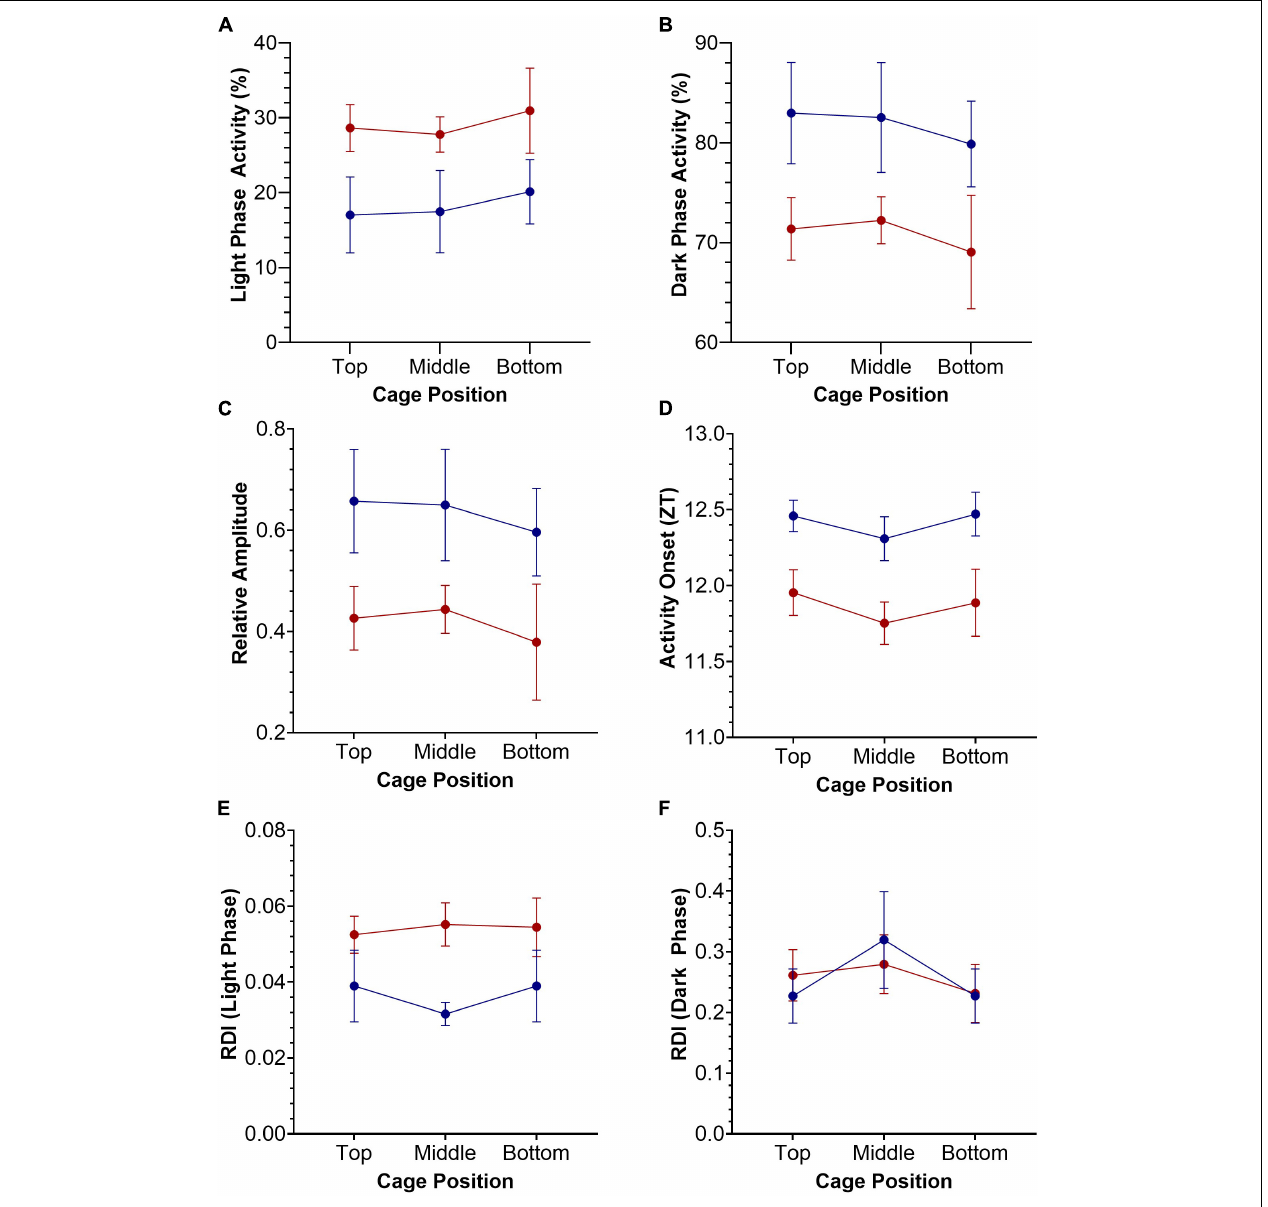
FIGURE 3 | Key circadian activity parameters plotted as mean +/– SEM for standard (blue) and red (red) cages, across top, middle, and bottom positions of the DVC rack. Two-way repeated-measures ANOVAs were used to test for significant effects of cage type and cage position. (A) Light phase activity (%), main effect of cage type [ F ( 1 . 0 , 9 . 0 ) = 4.196, p = 0.071]. (B) Dark phase activity (%), main effect of cage type [ F ( 1 . 0 , 9 . 0 ) = 4.196, p = 0.071]. (C) Relative amplitude, main effect of cage type [ F ( 1 . 0 , 9 . 0 ) = 4.151, p = 0.072]. (D) Activity Onset (ZT), significant main effect of cage type [ F ( 1 . 0 , 9 . 0 ) = 8.264, p = 0.018]. (E) Regularity disruption index (RDI)—light phase, main effect of cage type [ F ( 1 . 0 , 9 . 0 ) = 3.883, p = 0.080]. (F) Regularity disruption index (RDI)—dark phase, significant main effect of cage position [ F ( 1 . 8 , 16 . 6 ) = 5.545, p = 0.016].